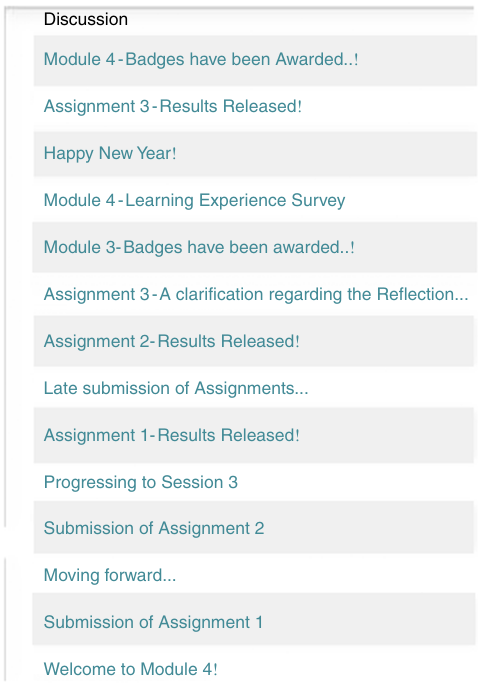
Figure 3. Sample of a news forum led by the